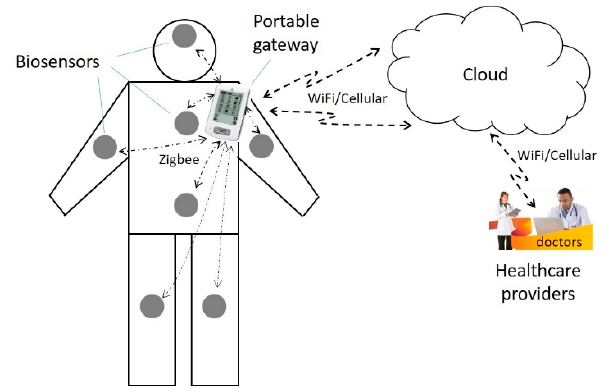
Figure 1. A typical healthcare IoT system infrastructure.